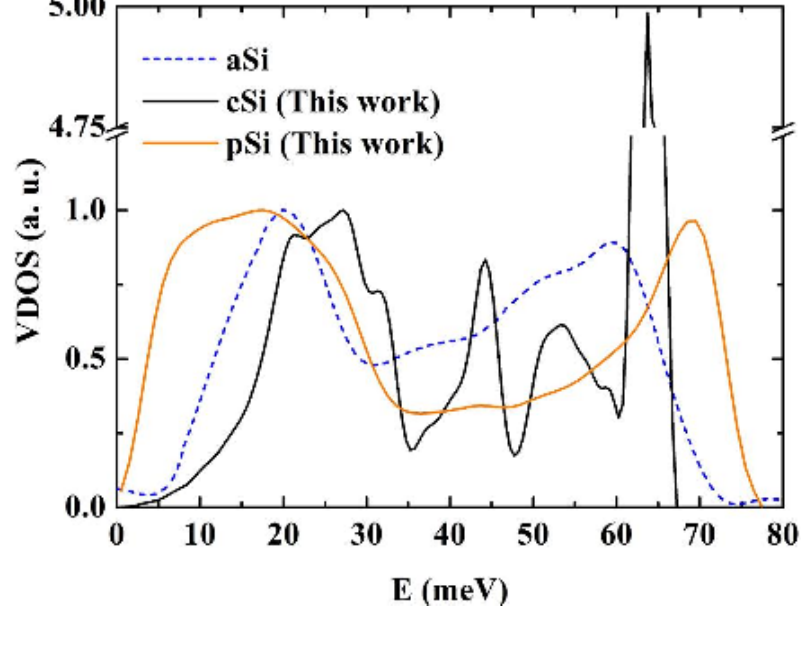
Figure 16. Vibrational densities of states (VDOS) for crystalline, c-Si, amorphous, a-Si [50], and porous, p-Si, silicon calculated using the Tersoff potential. The structures of the porous and the amorphous samples are enhanced. The units on the vertical axis are